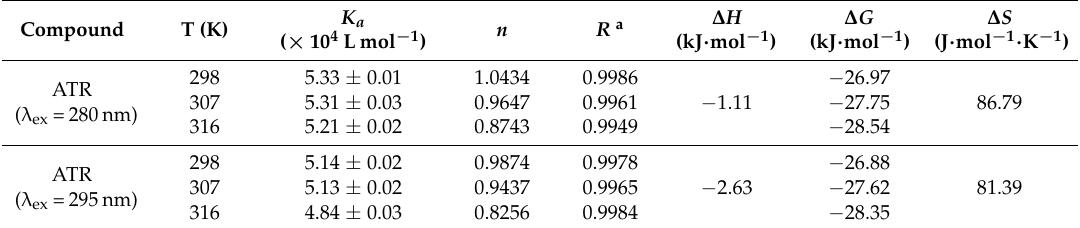
Table 2. Binding constants and thermodynamic parameters of the ATR to HSA.